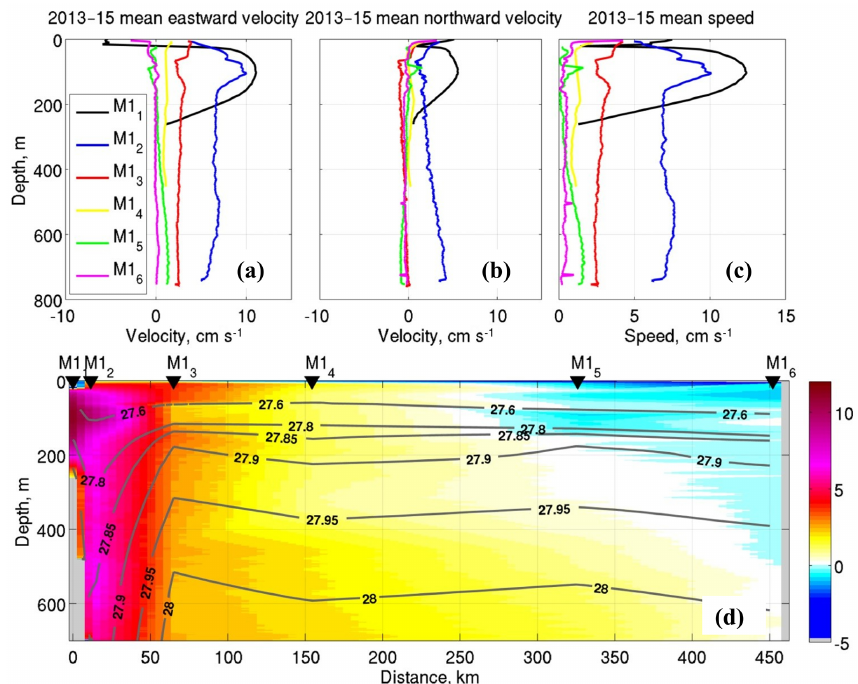
Figure 4. (a) Eastward and (b) northward velocities and (c) current speed at six moorings deployed at the Laptev Sea slope in 2013–2015; (d) distribution of the mean eastward velocity along the 125 ◦ E section. Gray contours show mean potential density calculated using 2013– 2015 temperature and salinity observations at